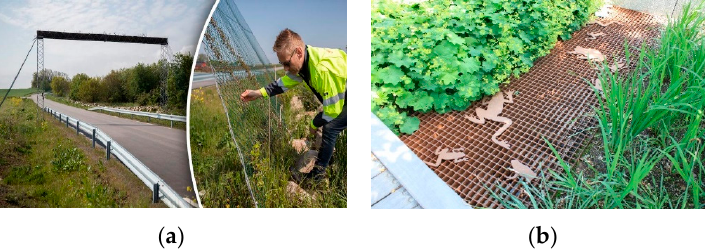
Figure 4. ( a ) A new road (serving an urbanized countryside) destroys the domain of the protected hazel mouse. To mitigate the e ff ect, the tra ffi c board installed a bridge for the mice to use. Two years after installation, the vegetation is not su ffi cient to make the bridge work as intended. (Photo: Skåne County Council website, visited 2019-05-30). All rights reserved) ( b ) To keep the rules for biodiversity in the National City Park in Stockholm, when building an adjacent dense urban district, a frog tunnel must be constructed, to allow frogs to move freely under streets and between and inside raingardens and ditches. (Photo: SWECO website, visited